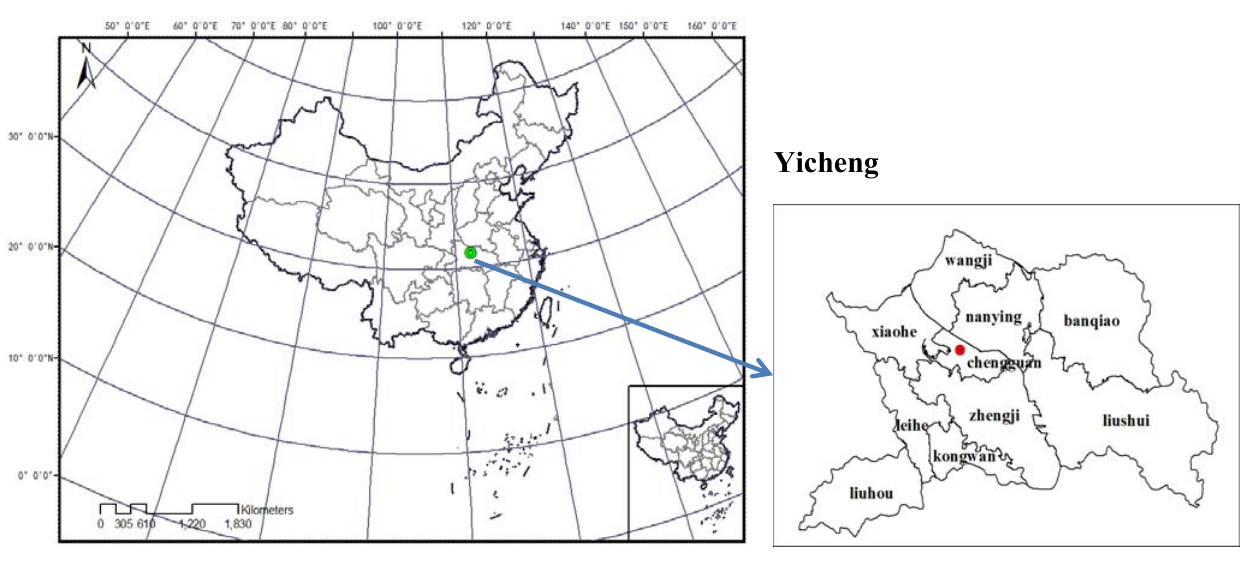
Figure 1. Location of the study area.